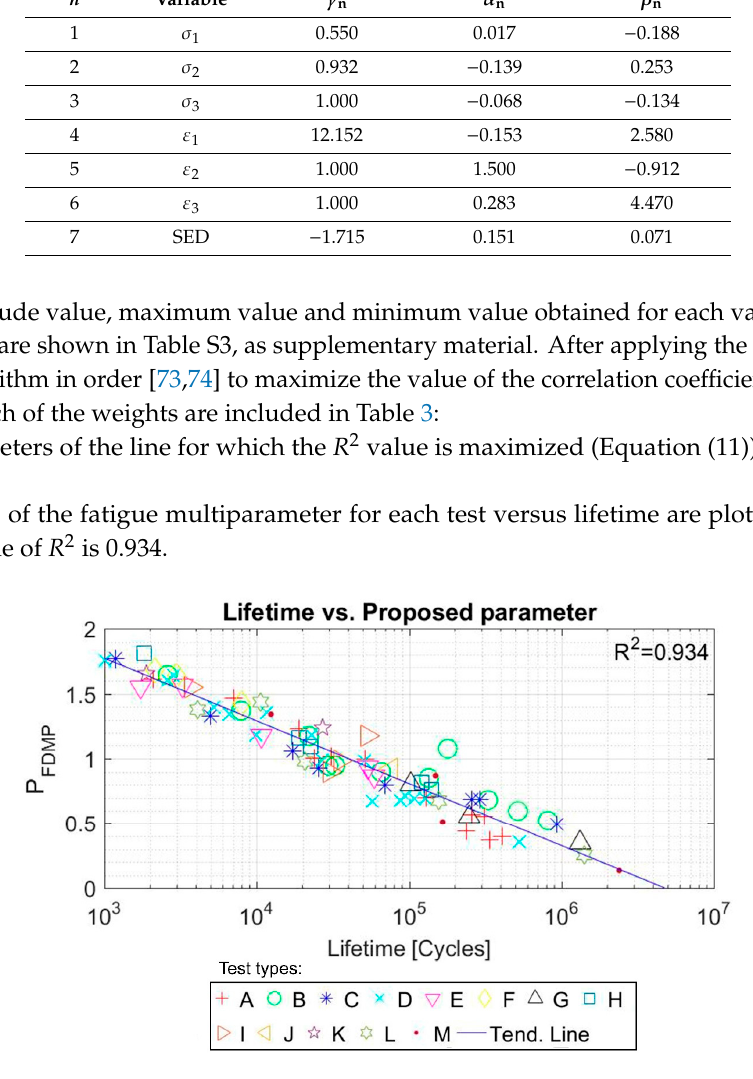
Table 3. Model weights of FDMP model for NBR tests. Initial data from [45]